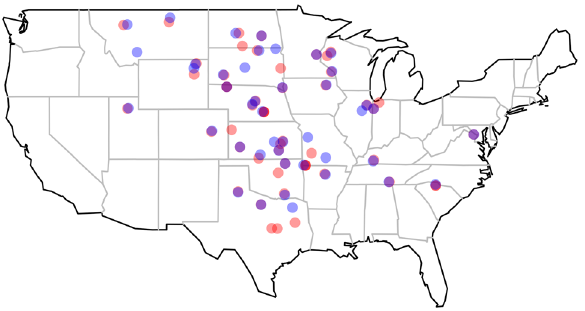
Figure 1. Map of sampling locations for herds sampled in 2018 (red) and 2019 (blue). Colors are semi- transparent such that herds sampled in both years appear purple. Map generated with maps package in R